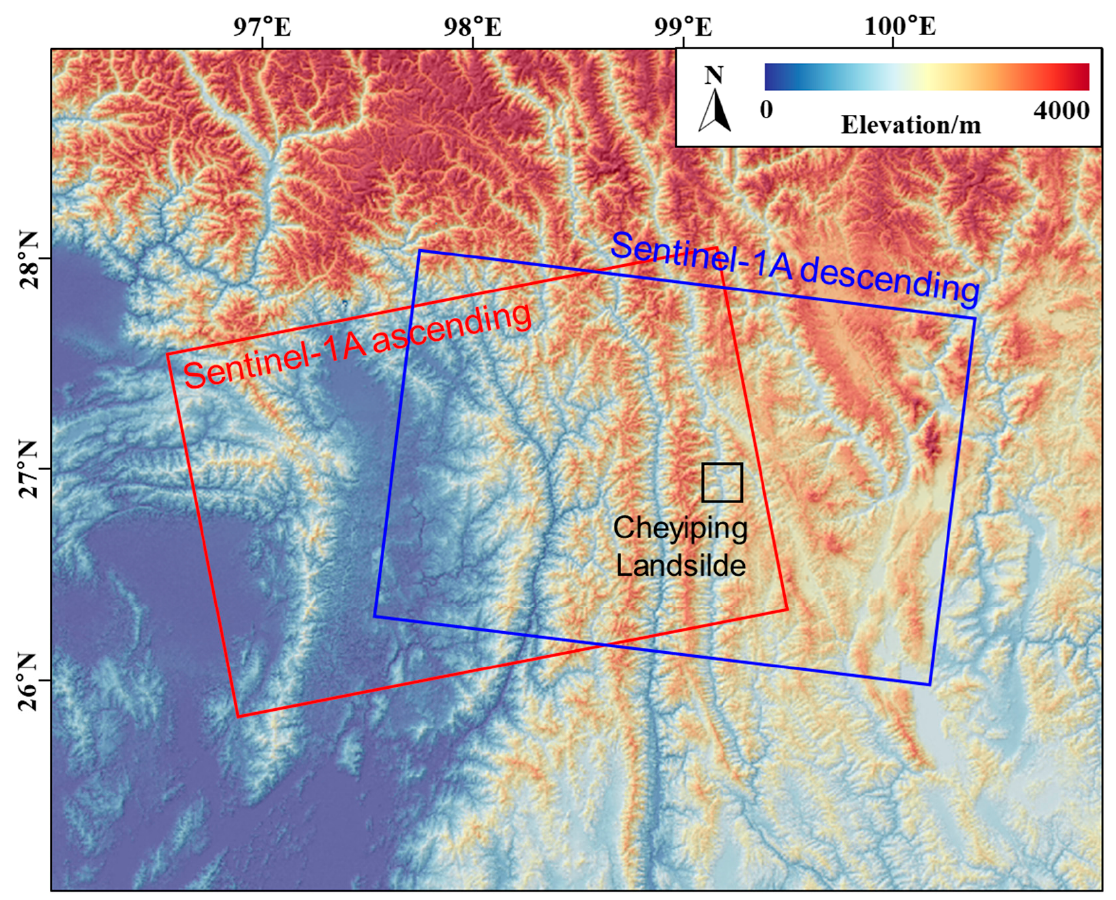
Figure 4. The spatial coverage of the SAR images. Table 1. Basic parameters of SAR images.